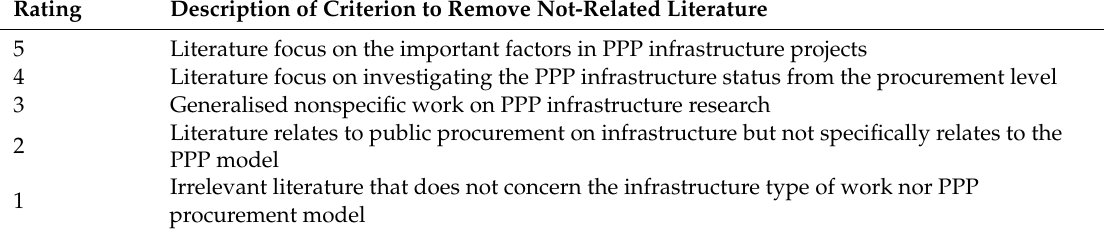
Table 1. Descriptions of rating criteria to remove irrelevant research